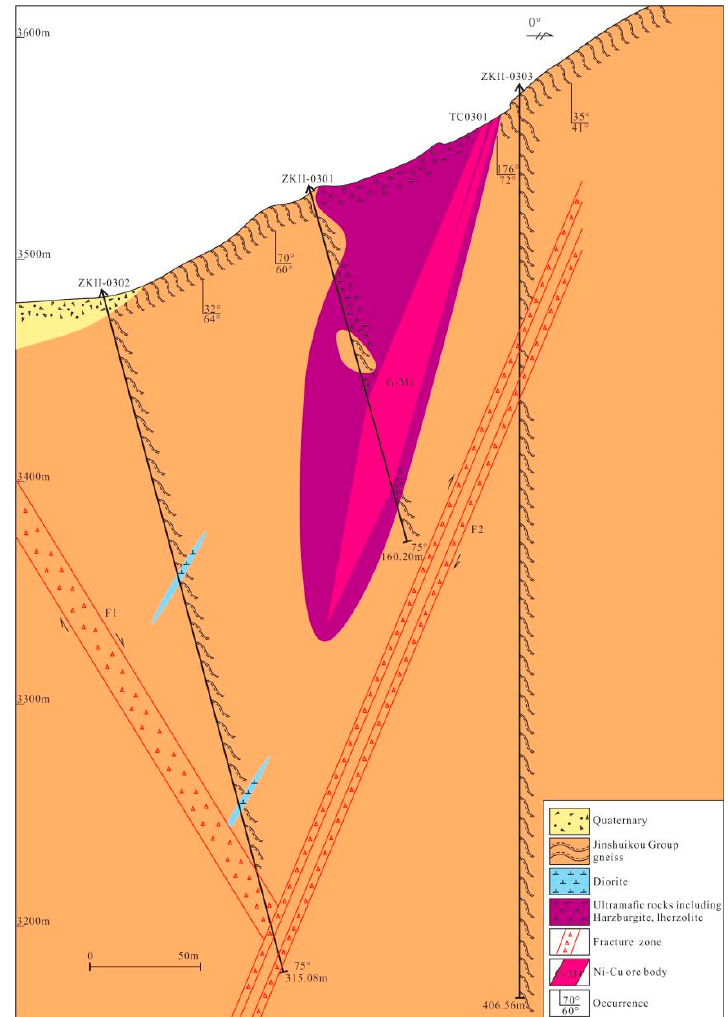
Figure 4. The line 3 section of the No. II ore block in the Niubiziliang Ni-(Cu) deposit (modified after Zhao et al. (2012a) [11]).